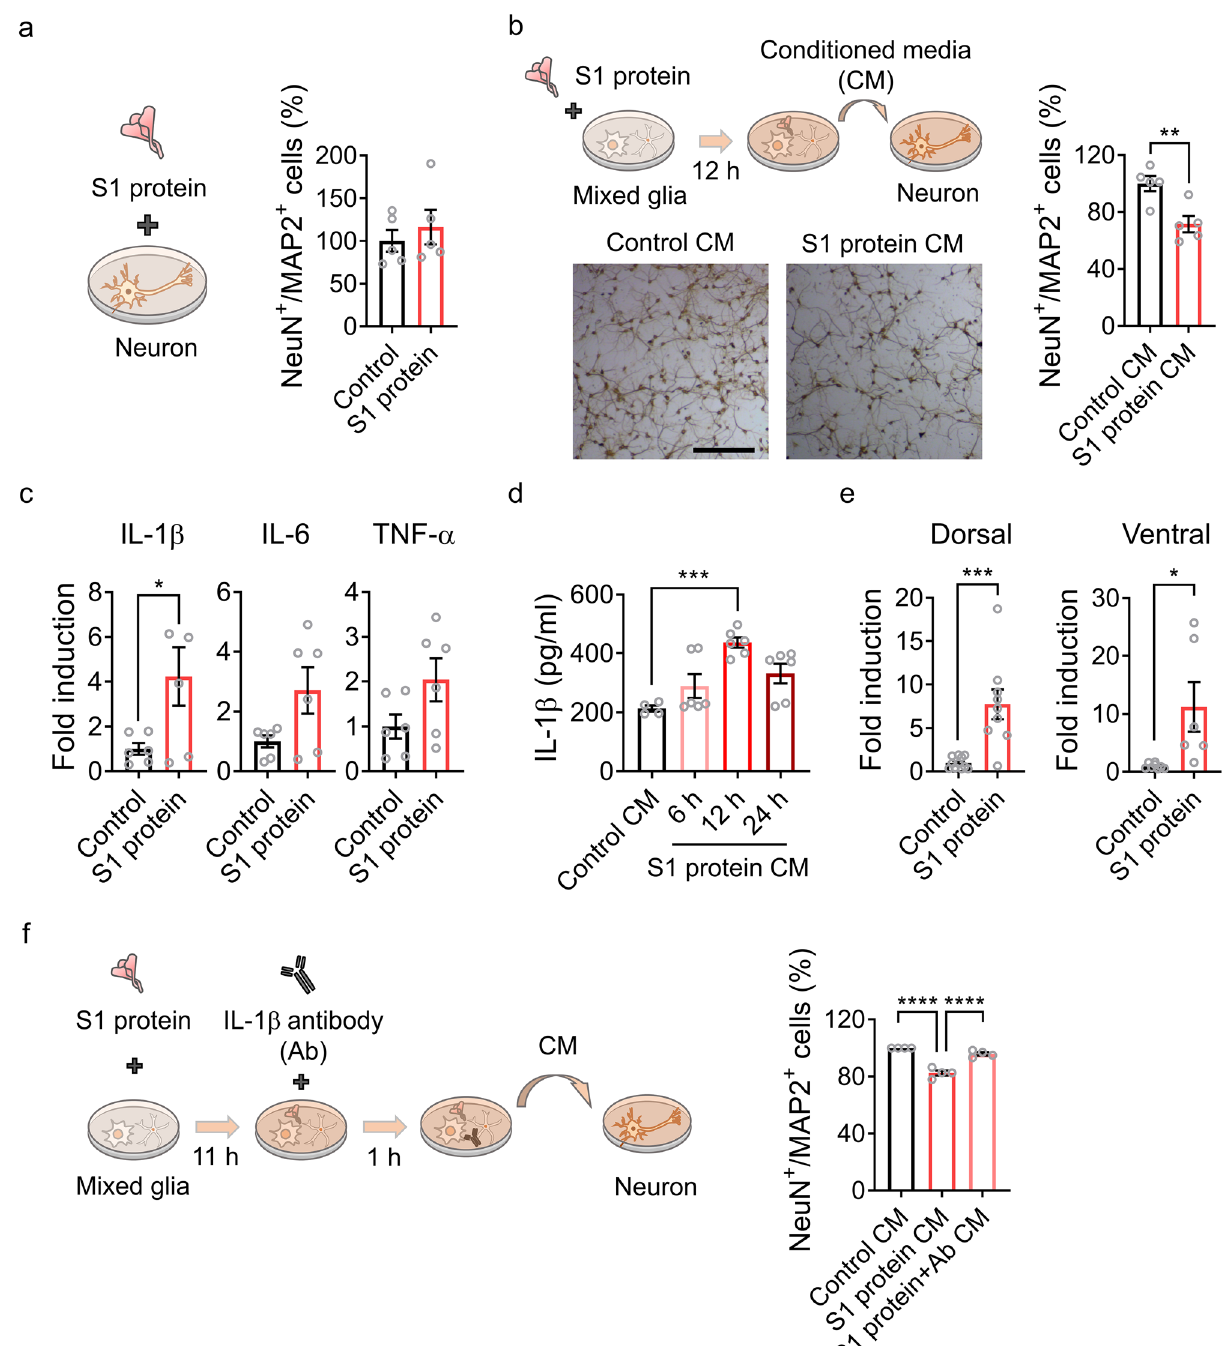
Figure 4. S1 protein induces non-cell autonomous hippocampal cell death via IL-1β induction in glial cells. ( a ) Primary hippocampal neurons were stimulated with S1 protein (5 µg/ml) for 12 h, and NeuN + and MAP2 + cells were manually and blindly counted. The relative cell numbers in S1 protein-treated samples compared to the control samples are shown (right). ( b ) A schematic diagram (upper) showing primary hippocampal neuron stimulation by S1 protein-activated glia-conditioned media (CM). After 12 h, neuronal cells were counted, and relative cell numbers in the CM-treated samples are presented (right). Representative images of hippocampal neurons with or without CM treatment for 12 h (bottom). ( c ) Primary glia were stimulated with or without S1 protein for 12 h. Total RNA was prepared, and transcripts of proinflammatory cytokines were measured by real-time RT-PCR analysis. The gene expression levels were normalized against GAPDH in each target and are presented as fold induction. ( d ) IL-1β protein levels in the CM of primary glia with or without S1 treatment were measured by ELISA. ( e ) IL-1β expression in the hippocampus in vivo 6 h after administration of S1 protein. IL-1β transcript levels in the dorsal and ventral hippocampus were separately examined. ( f ) An experimental scheme testing the neurotoxicity of glial cell-derived IL-1β in CM using IL-1β-neutralizing antibody. Pretreatment with IL-1β antibody for 1 h rescues hippocampal neuronal death by CM. Data are presented as the mean ± s.e.m. Statistical results are from unpaired t -tests. **** p < 0.0001, *** p < 0.001, * p <